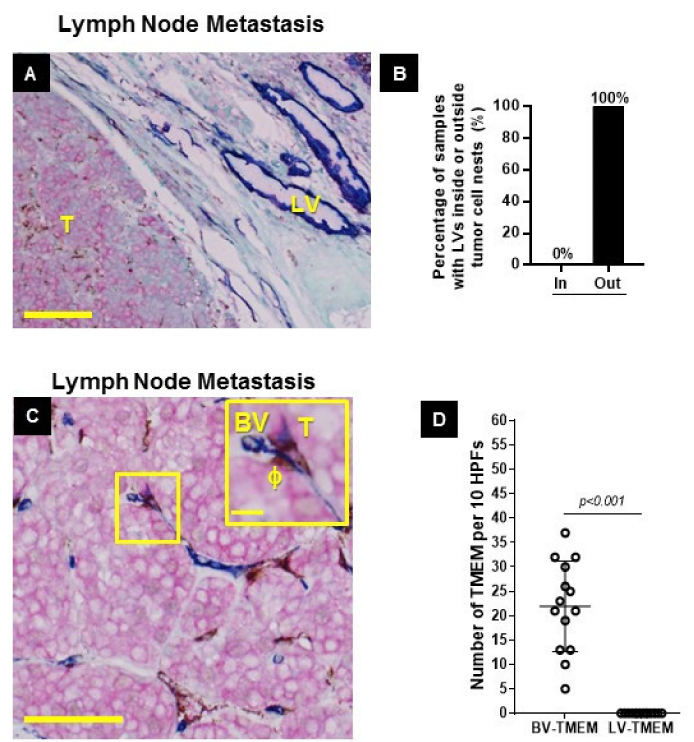
Figure 3. Blood vessel-tumor microenvironment of metastasis (BV-TMEM) are common in lymph node metastases and lymphatic vessel TMEM (LV-TMEM) are absent. ( A ) Metastatic tumor mass (T) in a breast cancer patient lymph node from a separate breast cancer cohort. The tumor mass, on the left, contains no LVs. LVs are only seen outside the tumor mass on the right (blue). ( A , C ) Pink = tumor cells (stained for pan-Mena), brown = macrophages (stained for CD68), blue = blood or lymphatic vessels (stained for D2-40 and CD31, respectively. Scale bar = 100 µ m. ( B ) Frequency (%) of LVs inside or outside the metastatic tumor mass in lymph nodes. ( C ) BV-TMEM in a lymph node of a breast cancer patient with a metastatic tumor mass. No LV-TMEM were identified within metastatic tumor masses. Scale bar = 120 µ m. Inset scale bar = 20 µ m. ( D ) Distribution of scores for BV-TMEM and LV-TMEM in the lymph nodes with tumor masses. The di ff erences between the BV-TMEM and LV-TMEM scores in each cohort are significant ( p < 0.001). See Table 5 for raw data. Table 5. BV-TMEM and LV-TMEM scores in lymph node metastasis. Sample ID